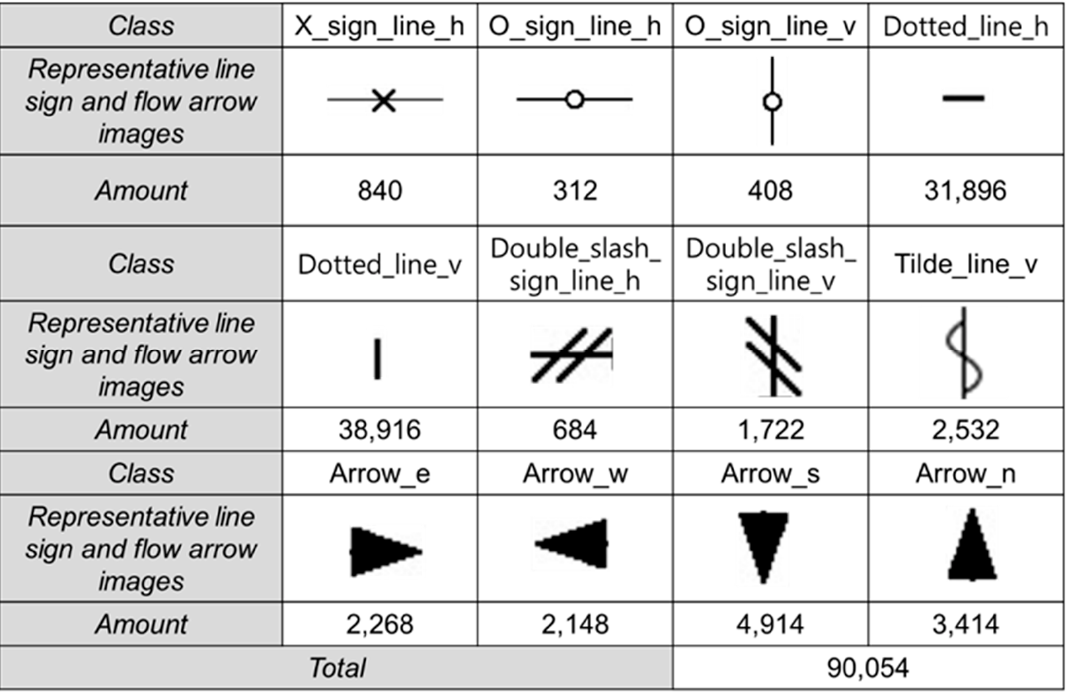
Figure 9. Summary of a final dataset of line objects.